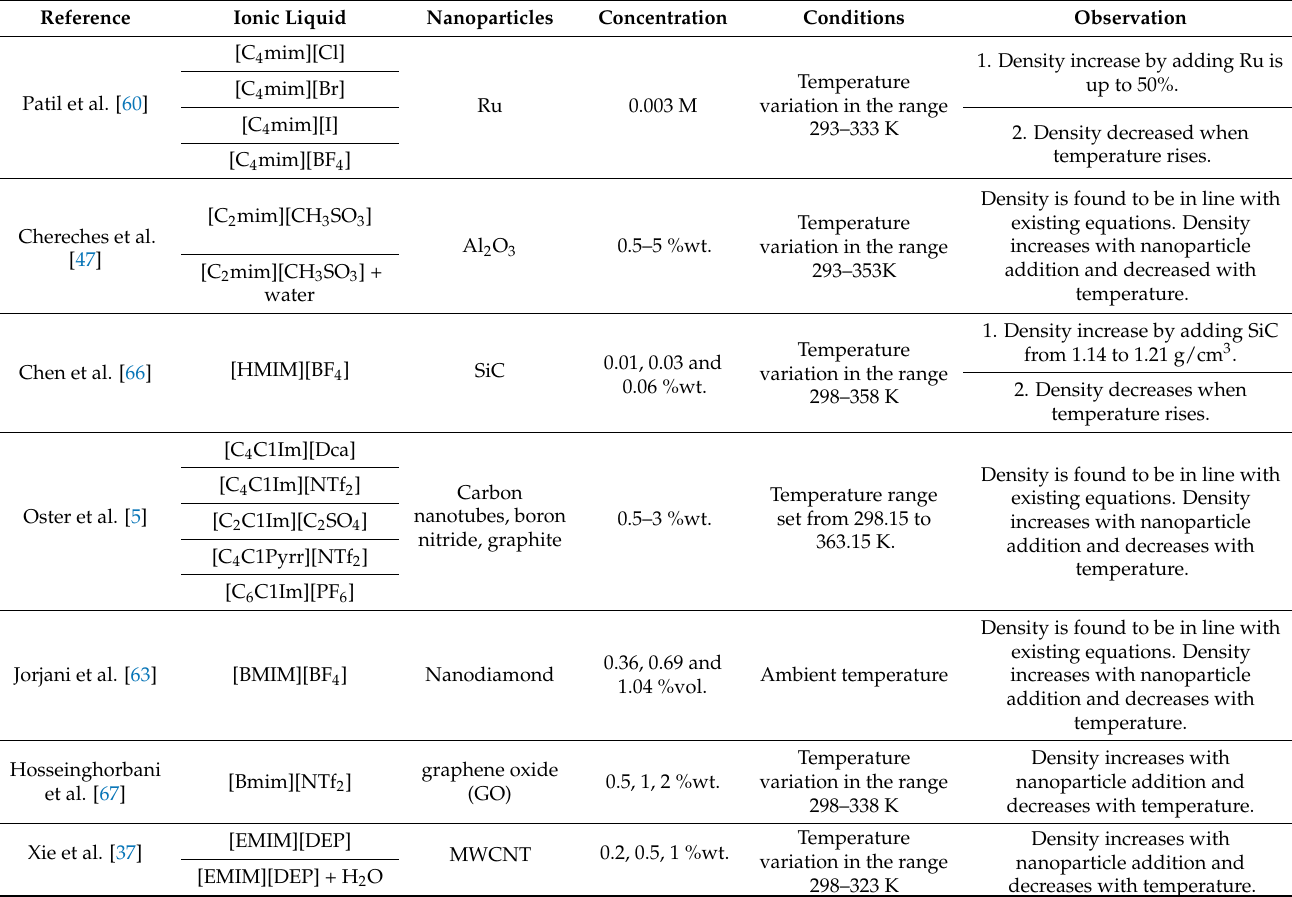
Table 6. Literature results on density of ionic liquid-based